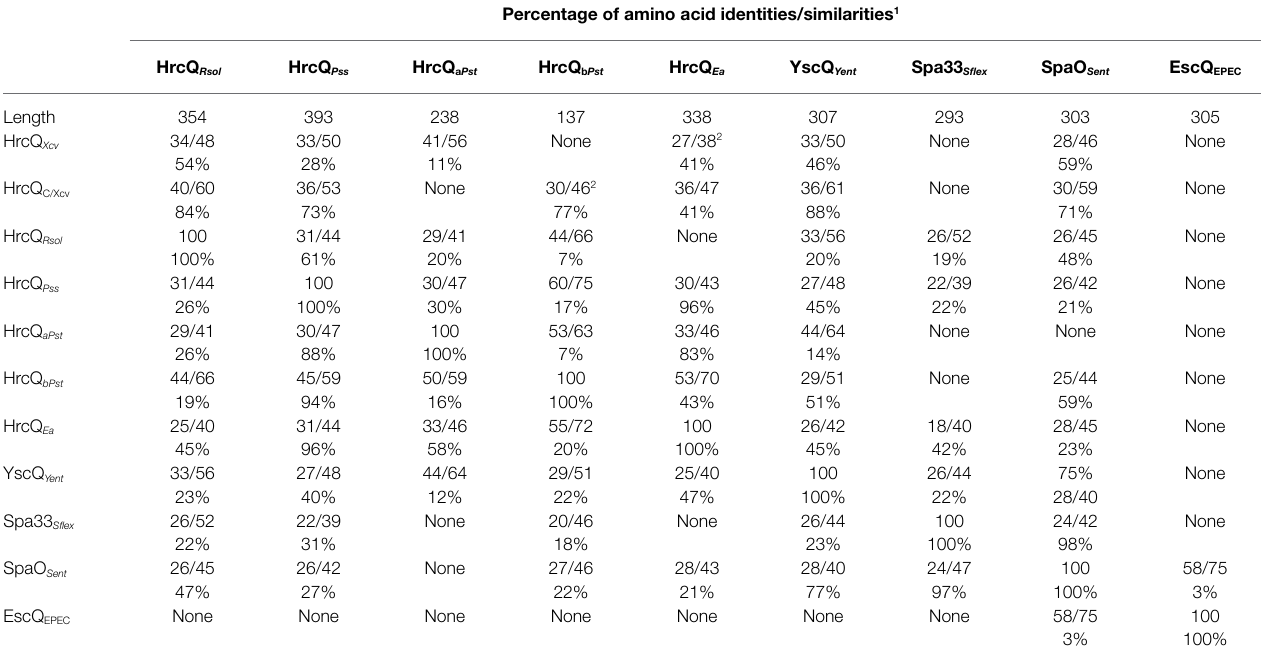
TABLE 1 | Amino acid similarities between HrcQ from Xanthomonas campestris pv. vesicatoria and HrcQ/SctQ proteins from other bacterial